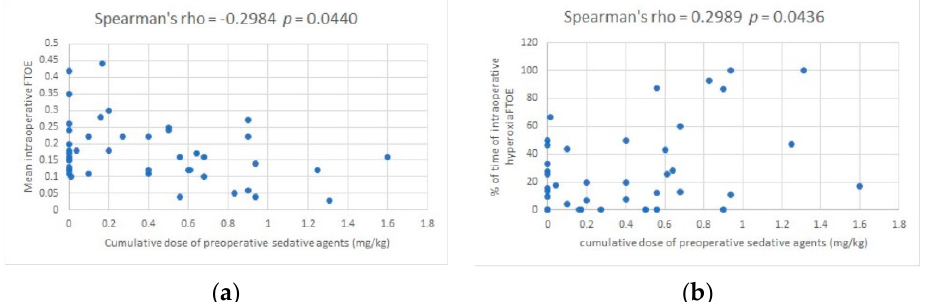
Figure 1. Correlation between the cumulative doses of preoperative sedative agents and cerebral fractional tissue oxygen extraction (FTOE) (by means of near-infrared spectroscopy) ( a ) Correlation between the cumulative doses of preoperative sedative agents and the mean intraoperative FTOE; ( b ) correlation between the cumulative doses of preoperative sedative agents and the % of time of intraoperative hyperoxia FTOE (when FTOE ≤ 0.1).